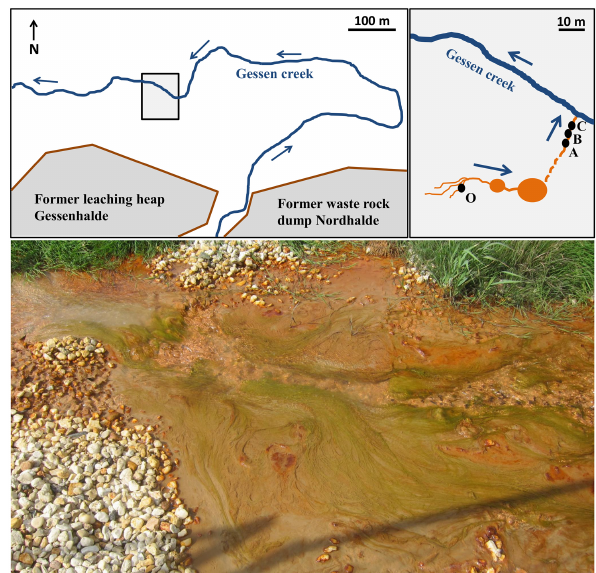
Figure 1. Schematic maps of the study site and photograph of site A in the former Ronneburg uranium mining district (Thuringia, Ger- many). Maps show the locations of sampling sites O, A, B, and C on the grassland close to Gessen creek. Blue arrows indicate the flow direction of the creek and outflow streams. The photograph was taken in September 2011 and shows the presence of conspicu- ous green filamentous